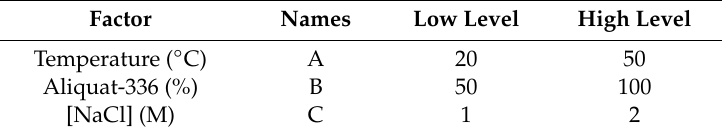
Table 3. Receiving phase factors and fields of study.